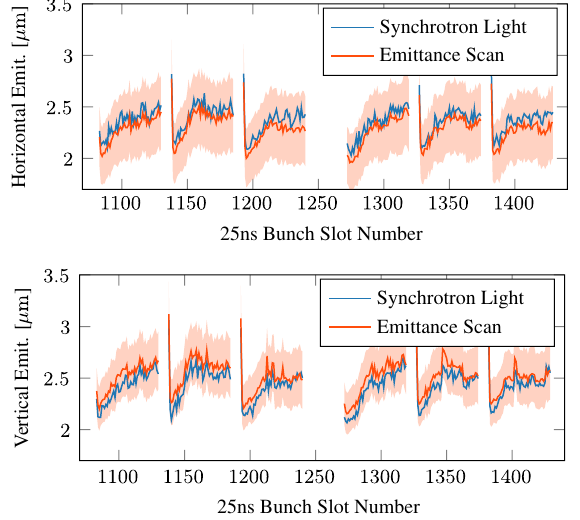
FIG. 12. Zoom on Fig. 11. The shaded error region for the emittance scan data includes both systematic and statistical uncertainties.